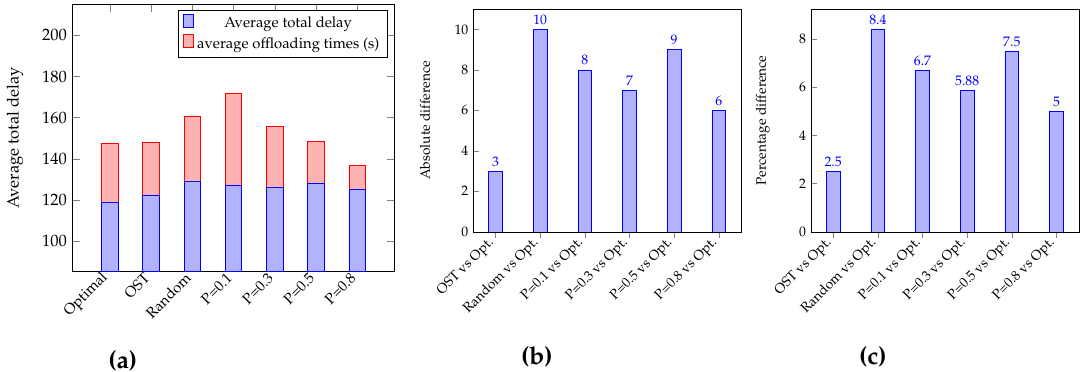
Figure 6. ( a ) Average total delay and average offloading times suggested by each model; ( b ) absolute difference between the Optimal and all models; ( c ) percentage difference between the Optimal and all models in Consecutive time-based mapping.